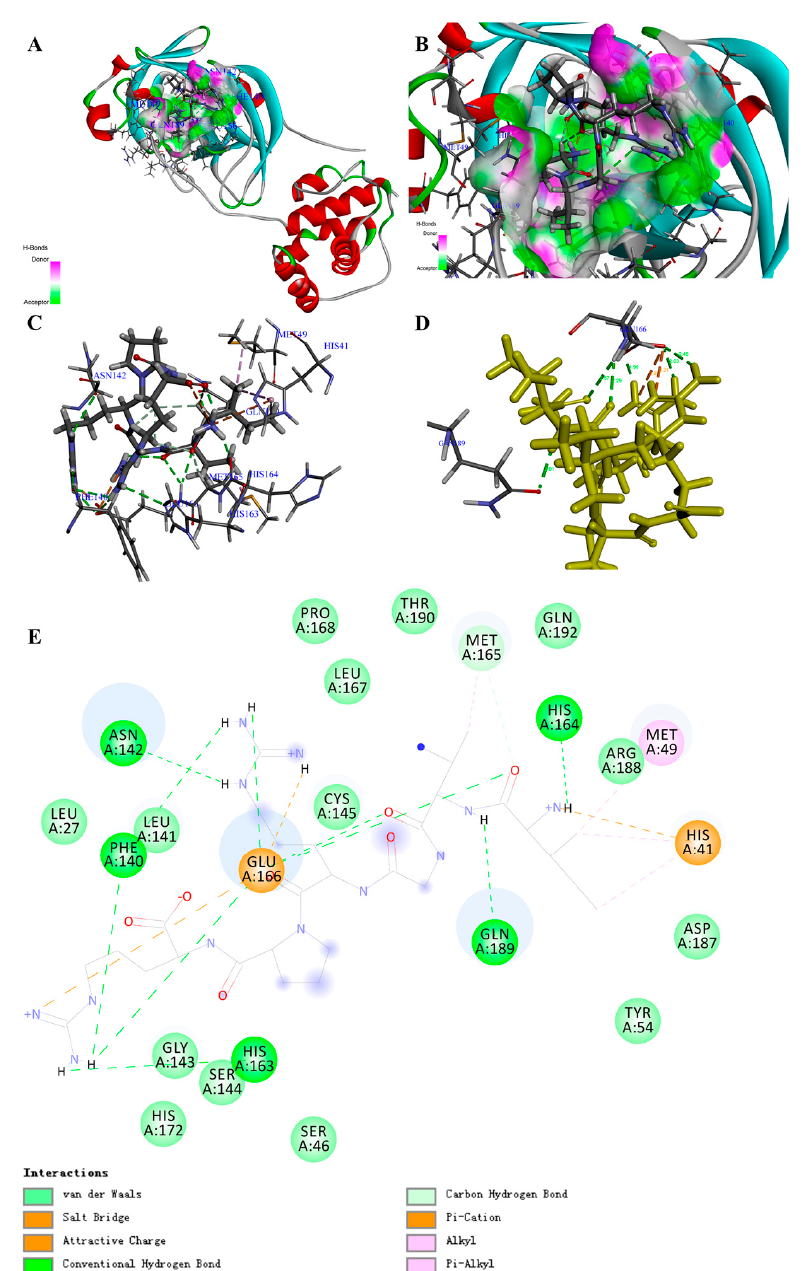
Figure 2. Structure of the COVID-19 virus main protease (COVID-19 virus Mpro) complex containing peptide (PM1) and its binding modes. ( A ) Three-dimensional (3D) structure of the COVID-19 virus M pro complex containing PM1. For clarity, the interface receptor amino acids residues are shown in thin stick style and PM1 is shown in thick stick style. COVID-19 virus M pro is downloaded from PDB (No. 6LU7) and generated in DS software with deleting the ligands. Different color represents different secondary structure, red is α -helix, blue is β -fold, green is β -turn, white is random coil. PM1 is the peptide, Ile-Val-Gly-Arg-Pro-Arg, with the highest total interaction energy to COVID-19 virus M pro . ( B ) Enlarged view of the interface in COVID-19 virus M pro complex containing PM1. ( C , D ) Binding site between PM1 and COVID-19 virus M pro and the main interaction residues. The dashed line with the different color represents the non-covalent interaction between PM1 and COVID-19 virus M pro . ( E ) 2D representation of interactions between PM1 and amino acid residues of COVID-19 virus M pro .